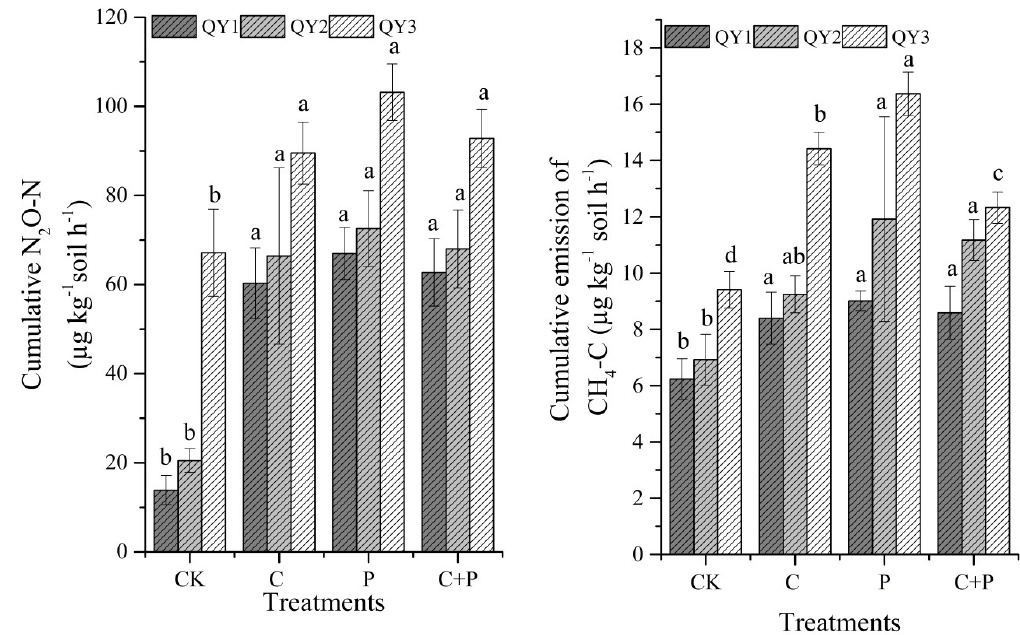
Figure 3. Mean cumulative N 2 O and CH 4 emissions from phosphorus-deficient (QY1) and -adequate soils (QY2, QY3) with and without glucose (Glu) and/or phosphorus (P) addition during 60 days of incubation. CK: control; C, glucose addition; P, phosphorus addition; C + P, glucose and phosphorus addition. Different letters indicate significant differences between treatments of each soil type. Error bars represent standard error (n = 3). Note: phosphorus-deficient soil is represented by QY1 and phosphorous-adequate soils are denoted by QY2 and